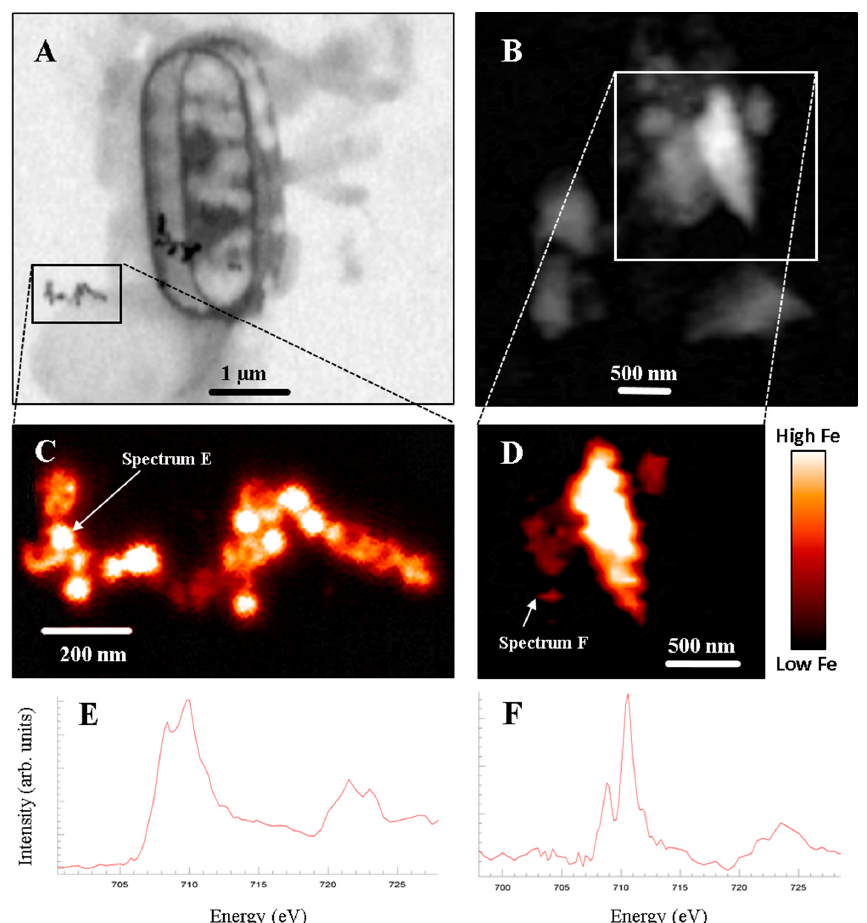
Figure 3. ( A , B ) X-ray absorption maps of marine nanoparticles collected at 709.8 eV using Scanning Transmission X-ray Microscopy (STXM)). ( C , D ) Fe distribution maps generated by subtracting the X-ray absorption map collected below the Fe L-edge (i.e., 703 eV) from the X-ray absorption map collected at the Fe L-edge (e.g., Figure 3A,B). Colour bar shows relative Fe concentration. ( E , F ) Fe L 2,3 -edge spectra for identified Fe-rich nanoparticles. Spectrum E reflects magnetite chemistry, whereas Spectrum F is indicative of Fe(III)—likely in the form of an amorphous Fe oxy-hydroxide phase. Similarities in cation size and charge result in Al-for-Fe substitution reactions being common phenomena in Fe oxides and Fe oxy-hydroxides. For example, natural soil Fe oxide minerals have previously been investigated and were found to contain levels of Al substitution reaching up to 36% [51]. Using Al subtraction maps generated by subtracting an X-ray absorption map collected below the Al K-edge (e.g., 1565 eV) from the X-ray absorption map collected at the Al K-edge (1572 eV), we were able to measure and compare the Al/Fe ratio in a subset of natural aquatic Fe nanoparticles to the Al/Fe ratio measured in natural aquatic particles >100 nm in size (Figure 4). The Al/Fe ratio in the nanoparticles ranges between 0.07 and 0.18; whereas the larger particles show a more extensive range spanning between 0.03 and 0.45. A student t-test conducted on the two datasets however, revealed that there is no significant difference ( α = 0.05) between the Al/Fe ratios measured in the two size fractions. The Al K-edge XANES spectra were also used to evaluate the ligand coordination around the Al metal center in the natural nanoparticles and larger particles [52]. The side panels in Figure 4